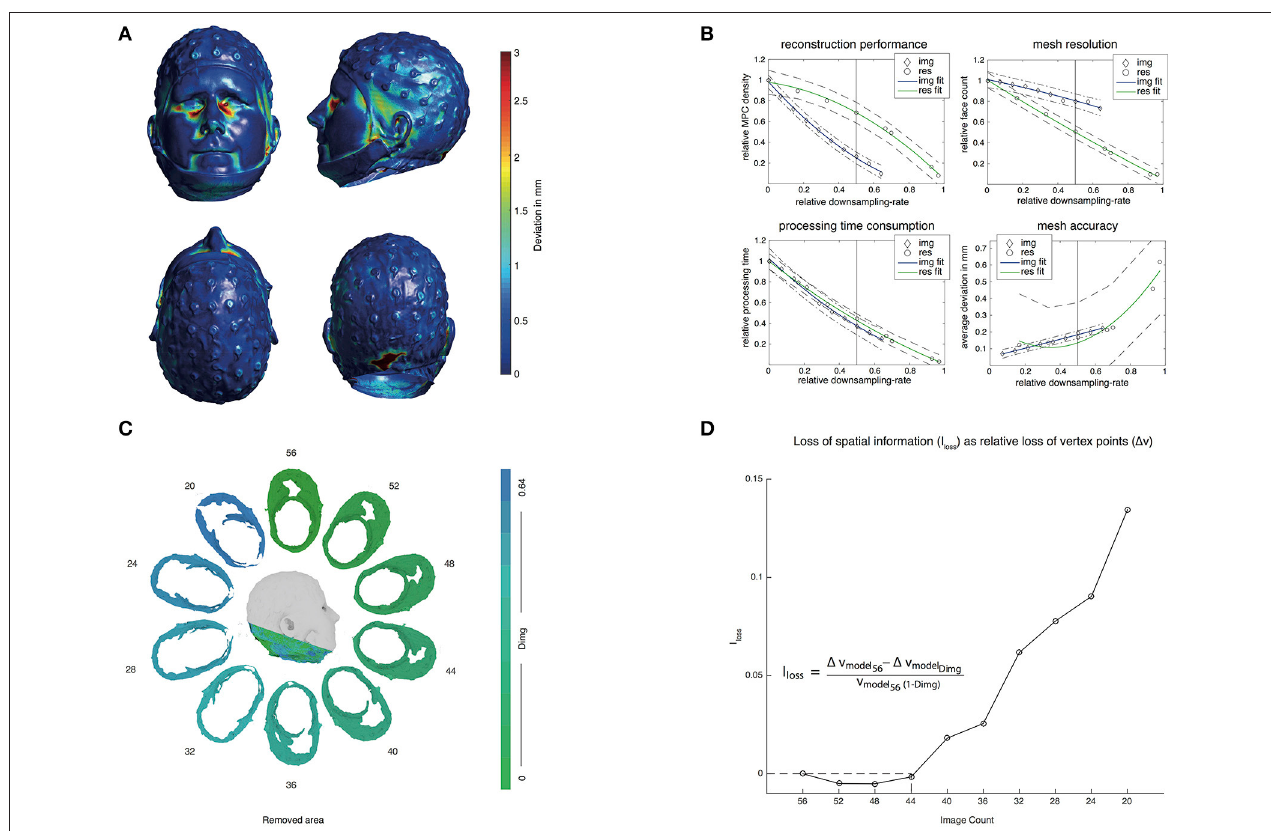
FIGURE 4 | (A) 3D meshes indicating the distance to the closest vertex point from the reconstructed model to the ground truth model obtained from FaceSCAN 3D . Difference values are plotted on the ground truth model. Vertex point distances are color coded, ranging from 0 mm to 2.95 mm (the 95 th percentile). (B) Descriptive curves for downsampling image count (Dimg) and image resolution (Dres). The blue and green lines indicate the quadratic fitting curves for the respective data. Dotted and dash-dotted lines indicate the respective 95% confidence interval of the fitting curves. X-axis values represent the relative downsampling rates corresponding to Table 1 . Top left plots the MPC density relative to the full-resolution model, top right likewise for DPC density, bottom left for overall time consumption relative to the full-resolution model and bottom right for the average deviation to the full-resolution model in mm. (C) An example showing the area that needed to be removed in order to make the meshes covering a comparable area for each downsampling step for image count. (D) Additionally loss of vertex points in order to make the meshes covering a comparable area for each downsampling step (Dimg). The dashed area indicates the not interpretable result of having a negative loss of information as a function of downsampling. At 50% downsampling, 7.8% of spatial information was lost.